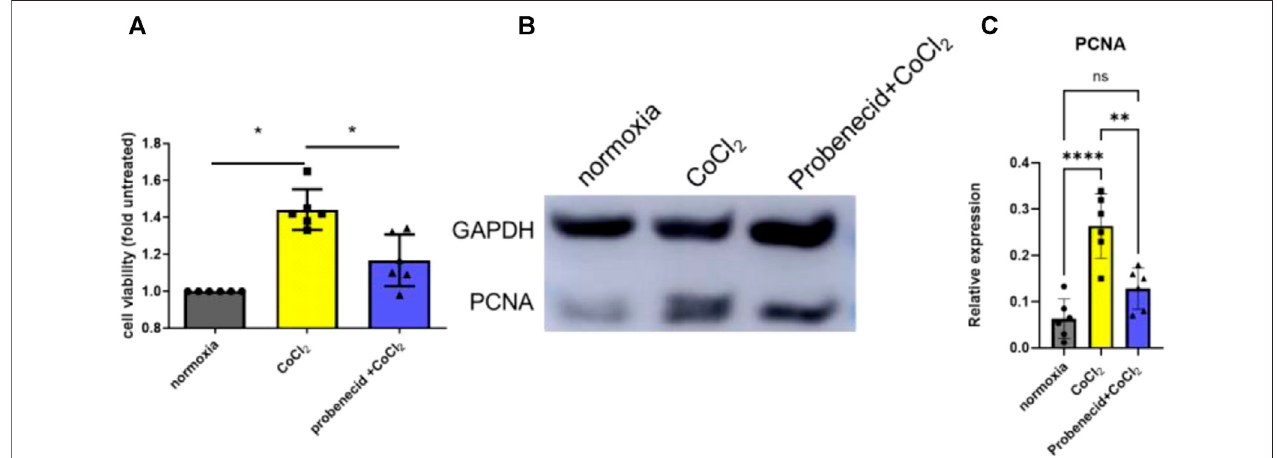
FIGURE 1 | Probenecid inhibits CoCl 2 -mediated retinal EC proliferation. Cells were pretreated with and without probenecid (150 μ g/ml) for 60 min prior to CoCl 2 exposure. MTT assay was conducted in human retinal ECs to analyze cell viability. (A) Bar graphs represent fold untreated of cell viability compared with normoxic conditions. (B) RepresentativeWBforPCNAexpression. (C) BargraphsrepresenttherelativePCNAlevelinthreeconditions.Resultsareexpressedasmean ± SD;n (cid:2) 6 for each group, * p < 0.05, ** p < 0.0015, and **** p < 0.0001. Signi fi cance was determined by one-way ANOVA with Tukey ’ s post hoc